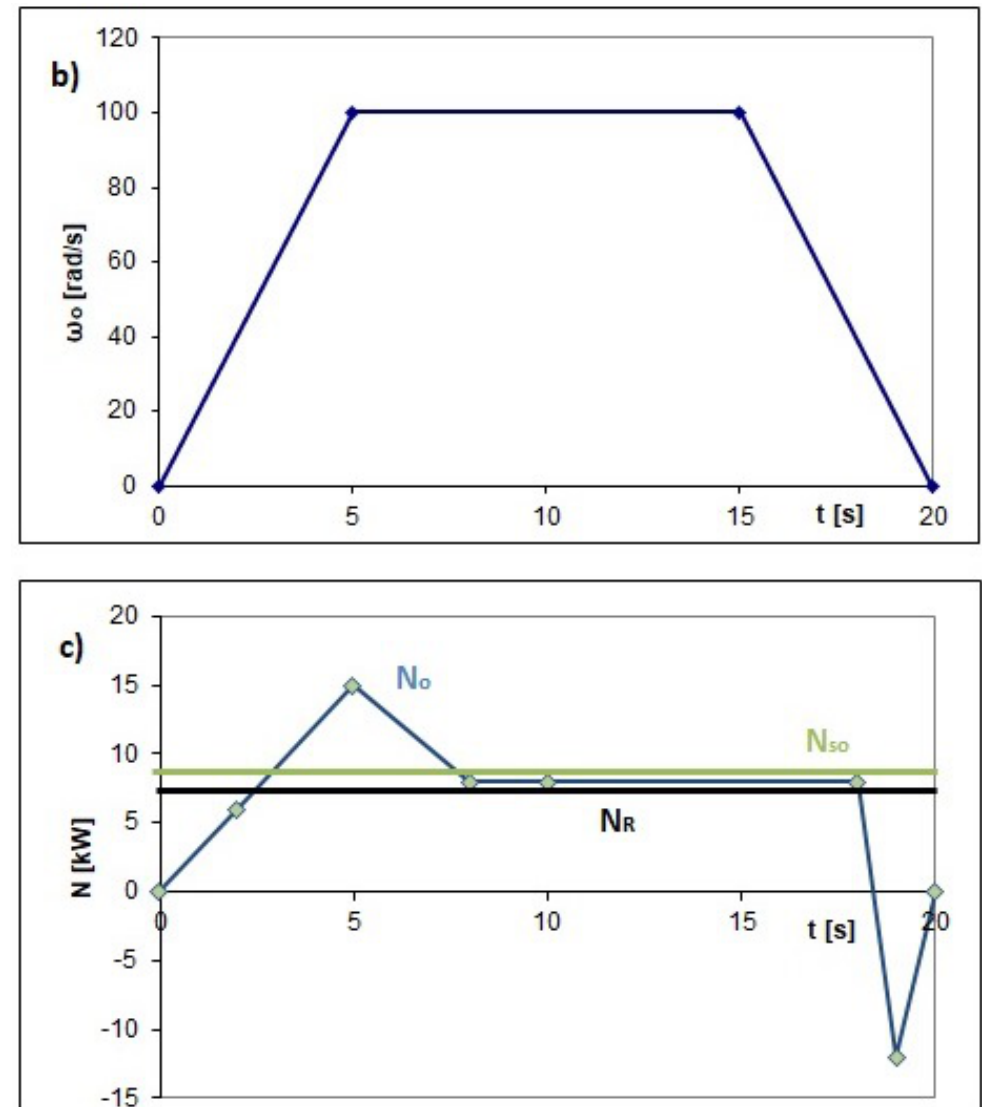
Figure 7. Exemplary load diagrams: ( a ) graph of angular velocity ω o ; ( b ) graph of load torque M o ; ( c ) N o : graph of load power; N so : power at which combustion engine runs in system with stabilization; N R : power at which combustion engine would run if recuperation system were included ( N : power; ω : angular velocity; M : torque; indexes: o :